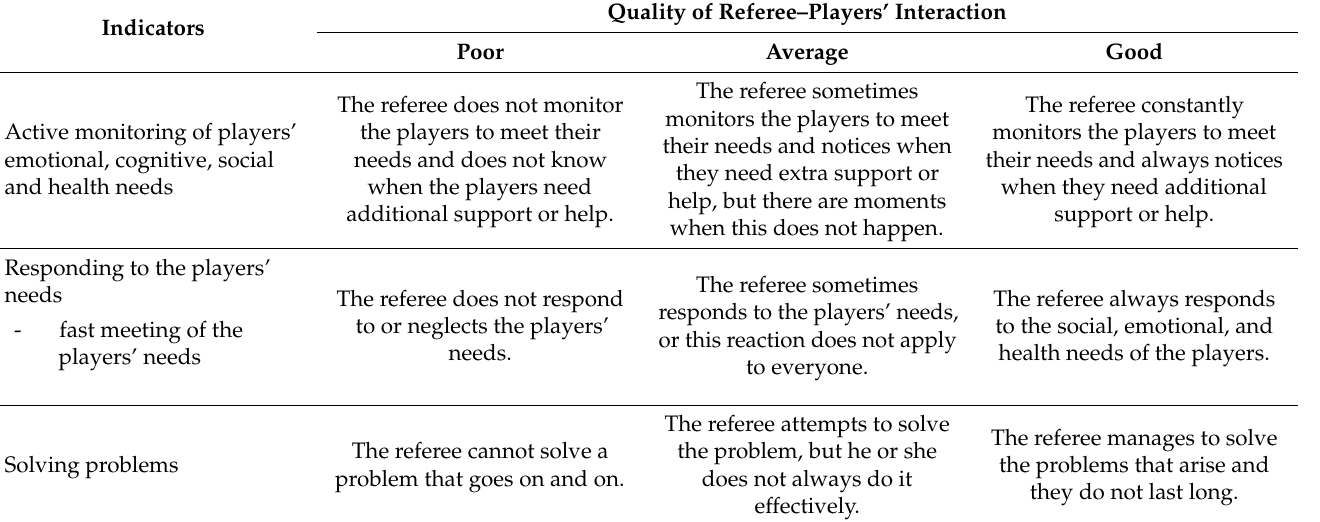
Table 2. Descriptions of indicators of responsiveness to the players’ needs [18].